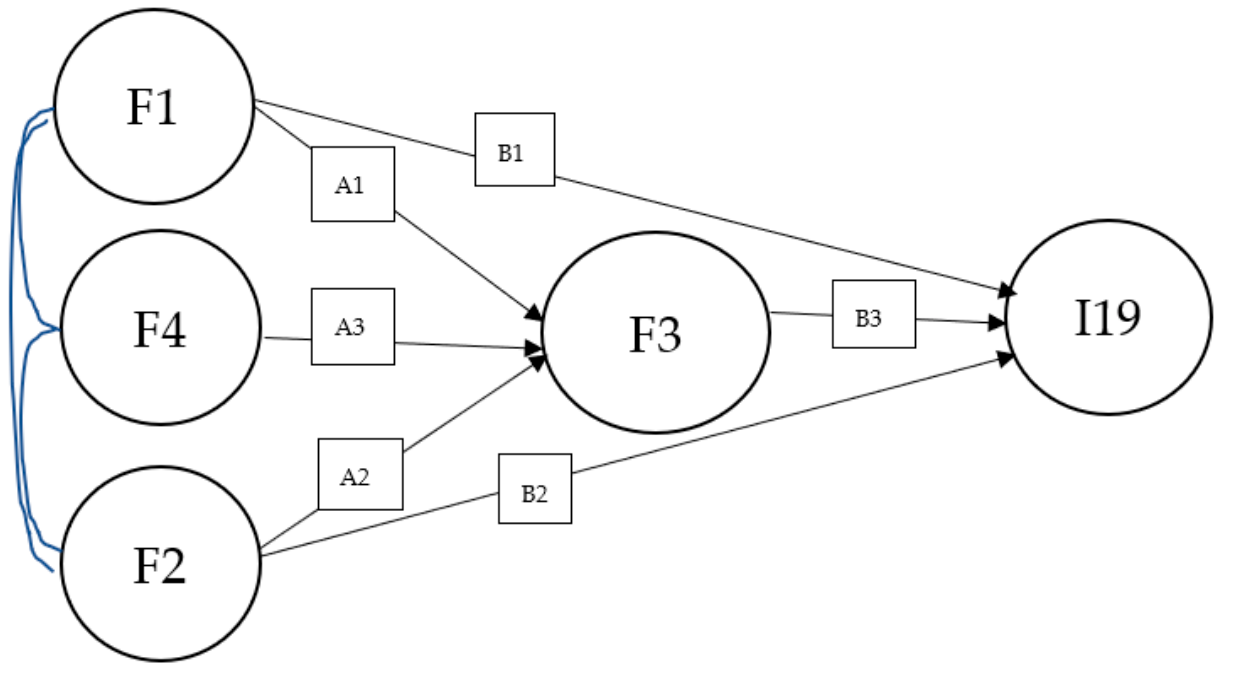
Figure 1. Structural equation model (SEM) meta-model.2.2. Linking Satisfaction and UGS Charac- teristics.